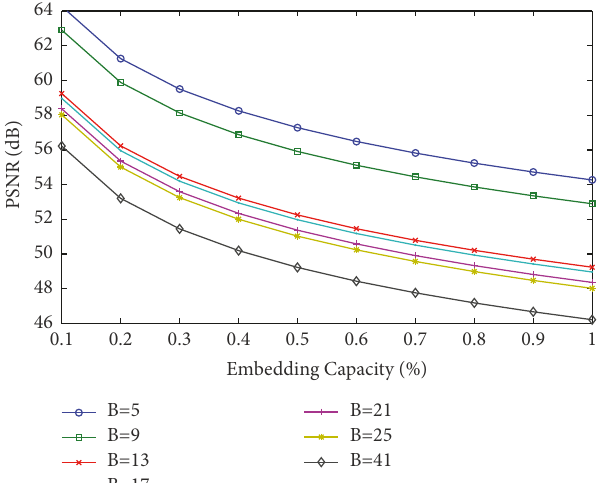
Figure 5: The relationships between embedding payload and image